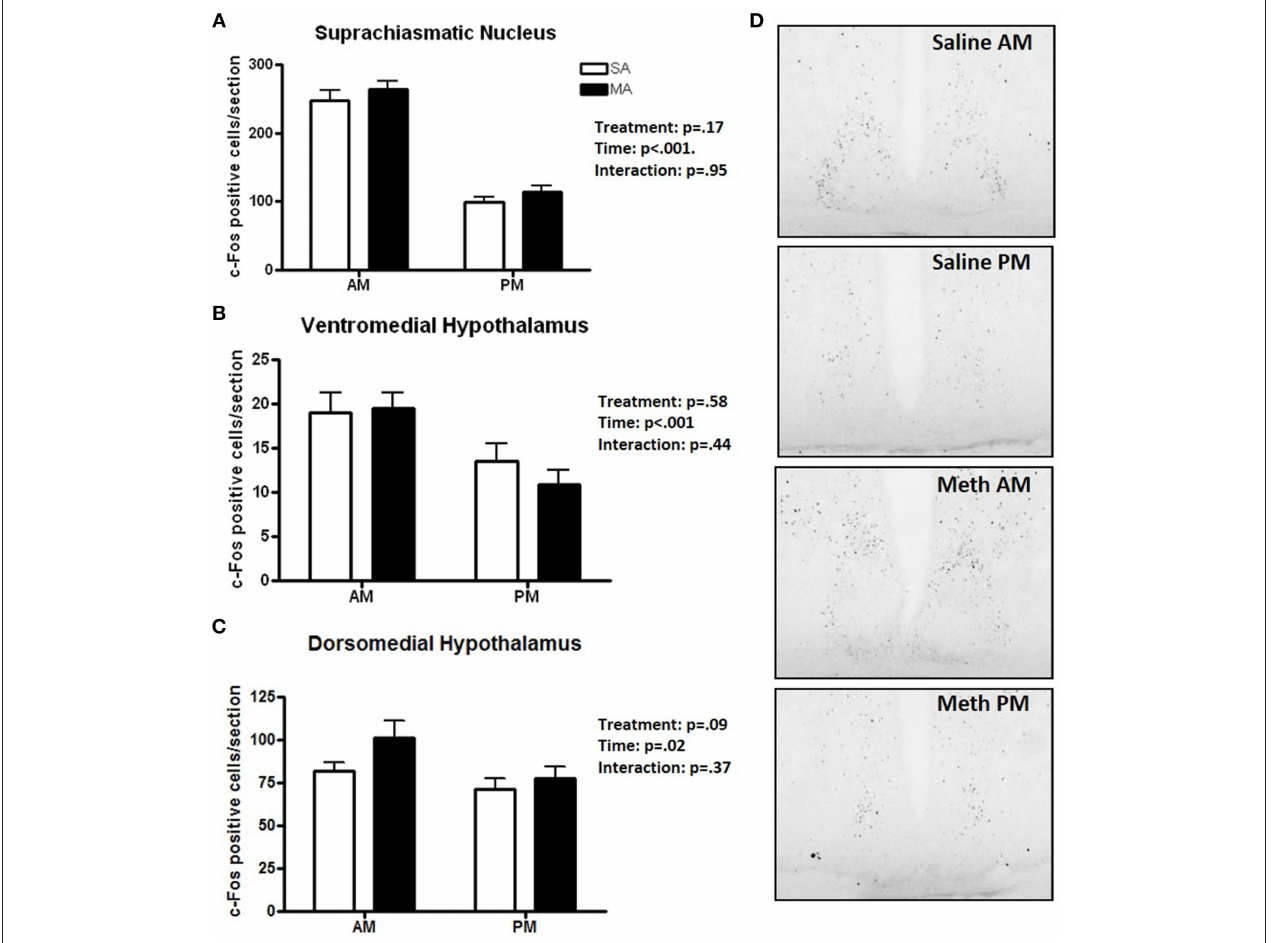
Figure 1F ]. Representative images for neuronal activation in the